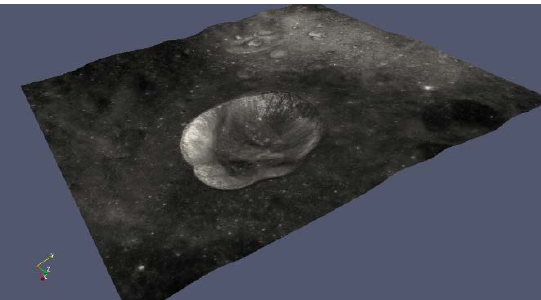
Figure 7. - The 3D visualization of a lunar crater generated using CE-2 high resolution ortophoto and NASA DEM (details in Zinzi et al.,